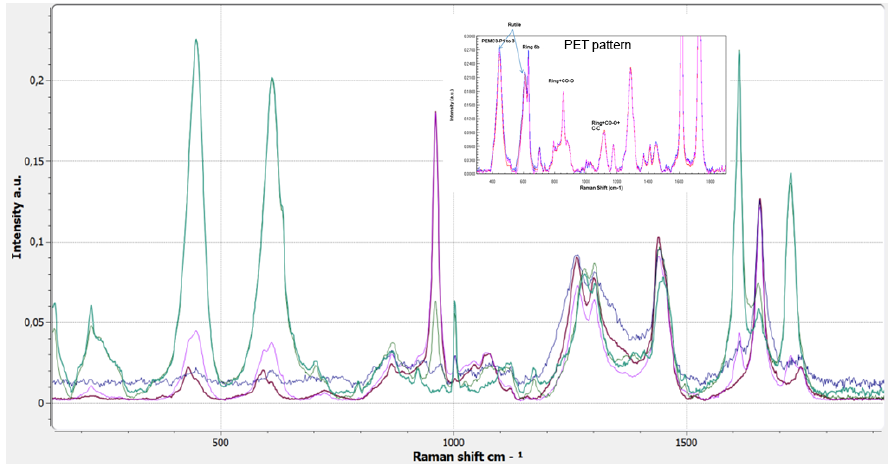
Figure 9. Raman spectra from Samples 1 (red) and 2 (green) corresponding to surface spots showing color changes after salmon adhesion.